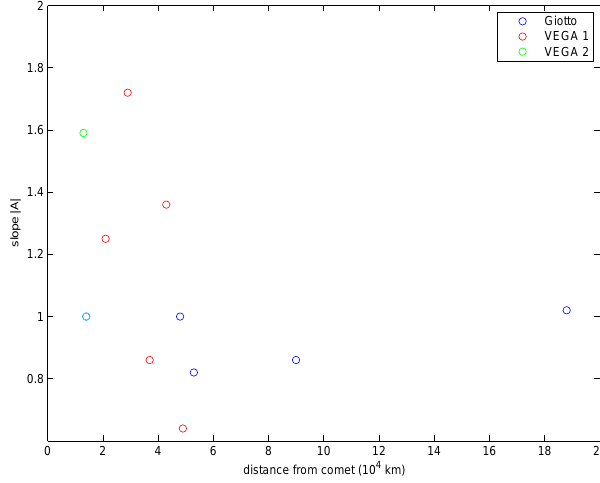
Fig.15. Theslope ofthedrapingfitasgiveninEq.(3)asafunctionofradialdistancetothecomet. Figure 15. The slope | A | of the draping fit as given in Eq. (3) as a | A | function of radial distance to the